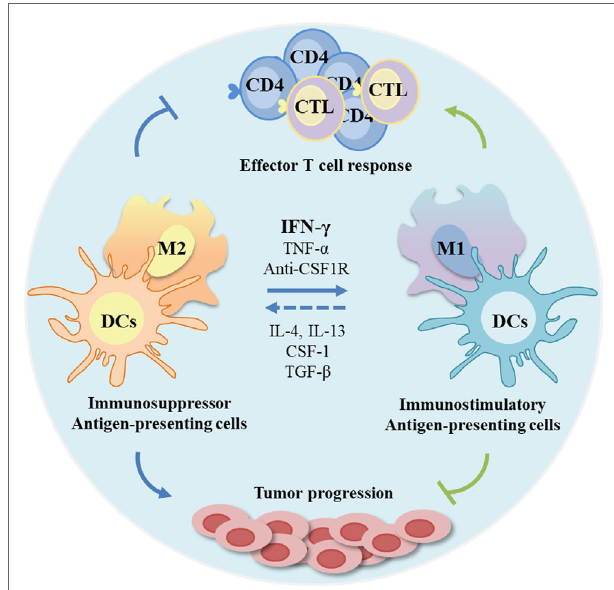
FiGURe 4 | Modulation of antigen-presenting cells (APCs) profile as anticancer therapeutic strategies. The tumor microenvironment is frequently immunosuppressive with APCs functions compromised, and consequently with poor T cell response. As APCs can be modulated by microenvironmental signals, these cells are promising targets. Interferon-gamma (IFN- γ ) and other molecules can be used to re-educate tumor-associated macrophages, frequently associated with anti-inflammatory status (M2-like) toward a pro-inflammatory and antitumor profile, while stimulating regulatory dendritic cells (DCs) to an immunostimulatory profile. This stimulation can potentiate effector T cell response and inhibit tumor